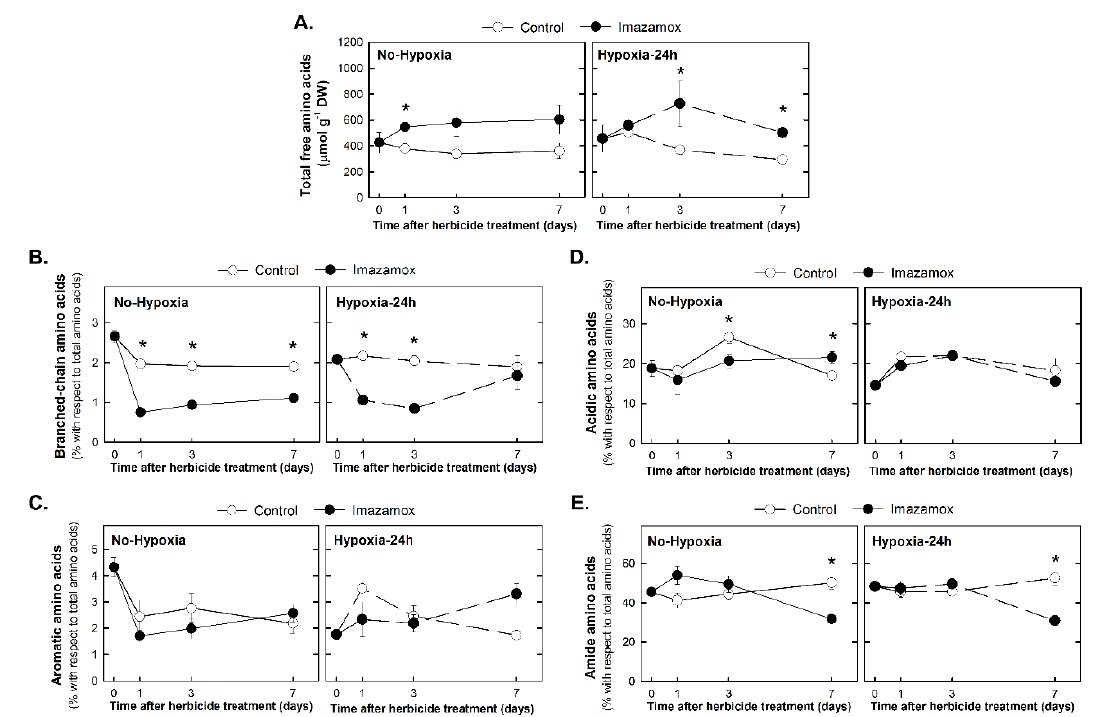
Figure 5. Free amino acid profile in the root of pea plants. Pea plants were not treated with hypoxia before herbicide application (Group No-Hypoxia) or were treated with hypoxia for 24 h before herbicide application (Group Hypoxia-24h). Half of the plants from each group were treated with imazamox (5 mg L −1 , black symbols). In each group, the other halves were not treated with herbicide and were used as the controls (white symbols) for the imazamox-treated plants. Total free amino acids ( A ) branched-chain ( B ) aromatic ( C ) acidic ( D ) and amide ( E ) amino acid contents. Values represent the mean ± SE ( n = 4 biological replicates). Significant variations are marked with * for differences between control and imazamox-treated plants ( t -Test, p < 0.05) at a given day. See Supporting Information Table S1 for the two-way ANOVA results .